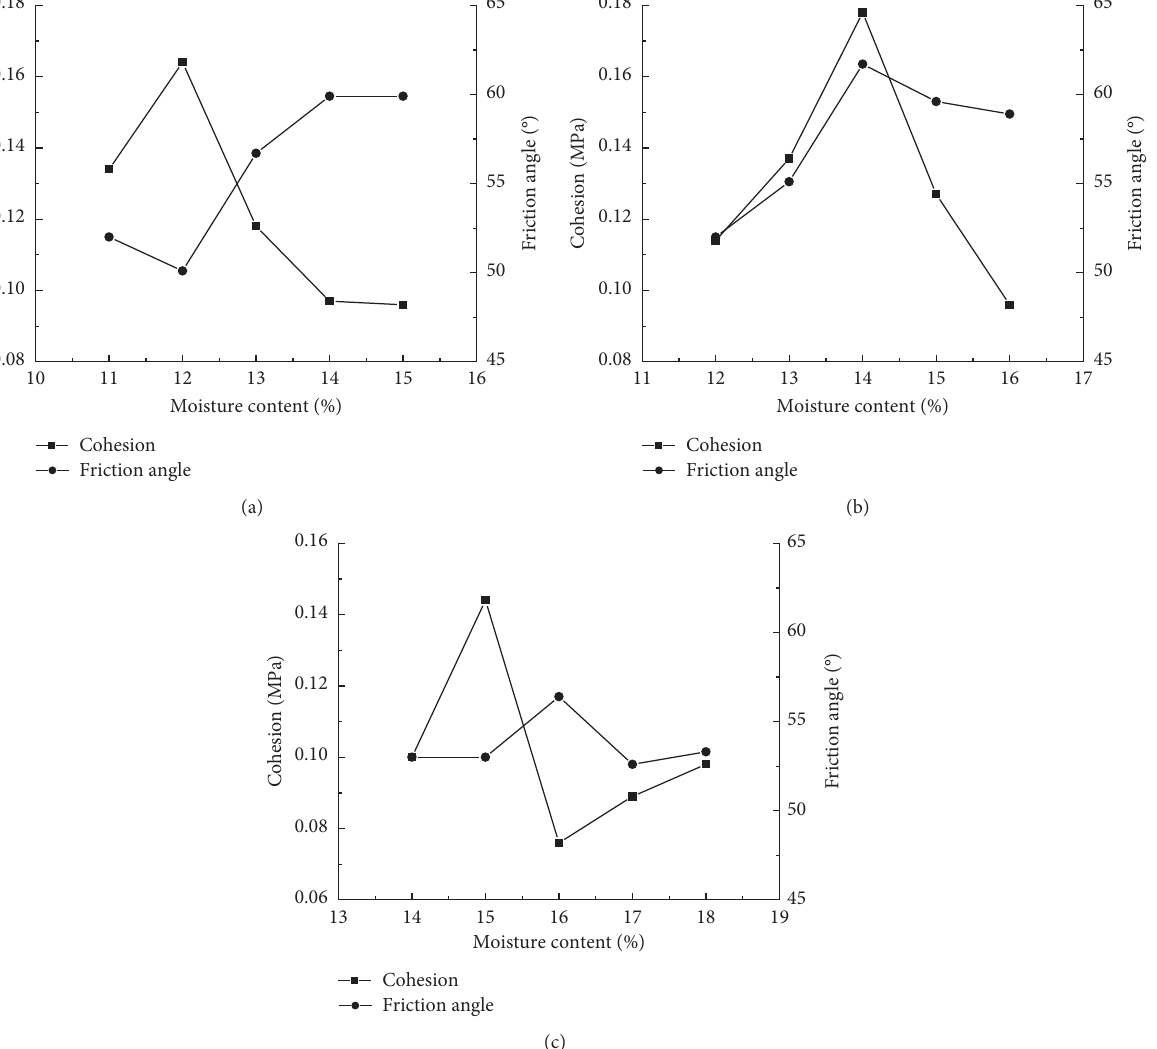
Figure 6: The variation of cohesion and friction angle of soil-rock mixture at different moisture contents. (a) Gradation 1. (b) Gradation 2. (c) Gradation